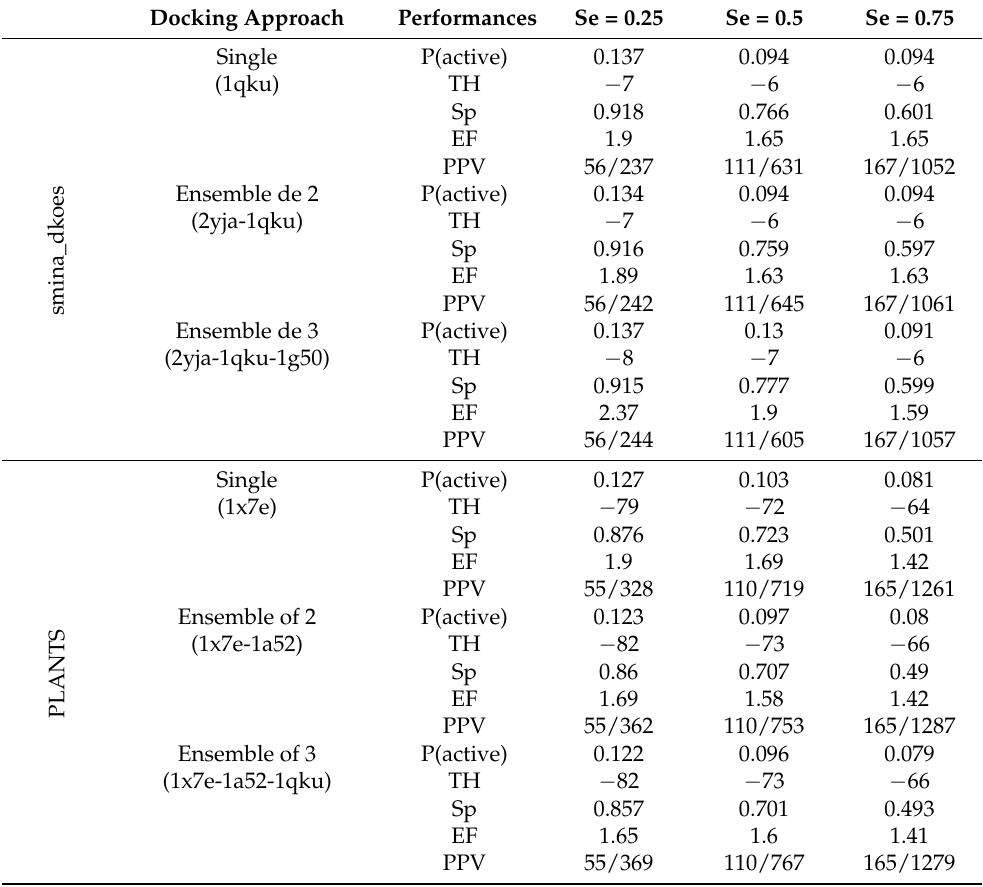
Table 2. P(active), scoring threshold (TH), Specificity (Sp), Enrichment factor (EF), and the positive predictive value (PPV) calculated for different values of sensitivity (Se) (0.25/0.5 and 0.75) for all the docking approaches and for the scoring function smina-dkoes and Protein–Ligand ANT System (PLANTS).